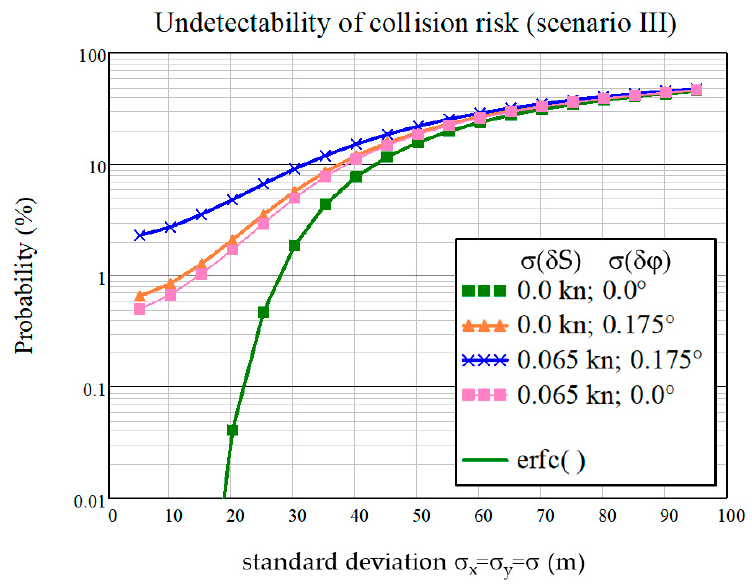
Figure 14. Impact of position, COG and SOG inaccuracies on the detectability of existing collision risks dependent on the standard deviation σ of position errors (L = 100 m, provided for a forecast time δ t = 18 min, equally distributed SOG values between 0 and 25 kn and equally distributed COG values between 0° and 360°).